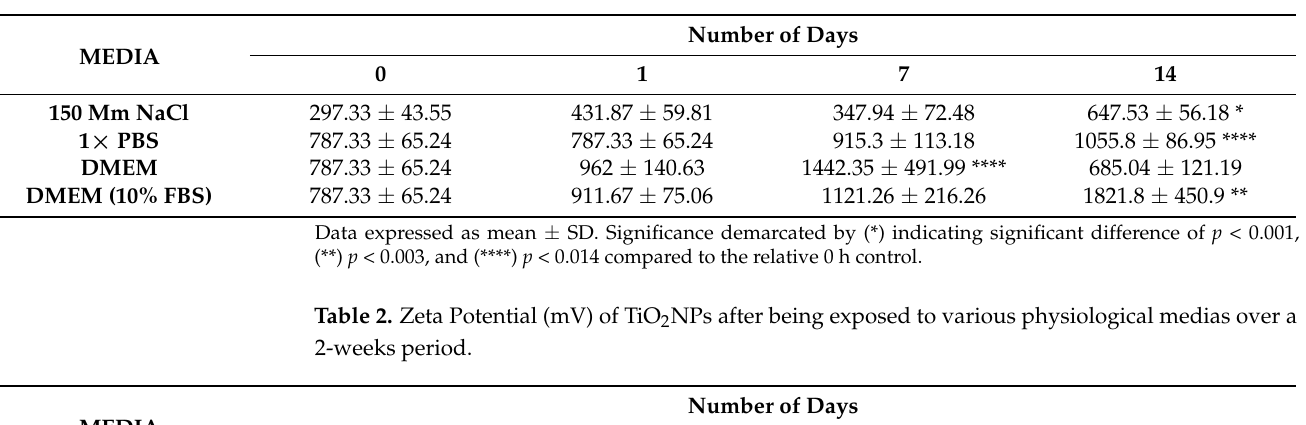
Figure 2. X-ray crystallography (XRD) analysis of TiO 2 NPs. Table 1. Hydrodynamic diameter (nm) of TiO 2 NPs after being exposed to various physiological medias over a 2-weeks period.